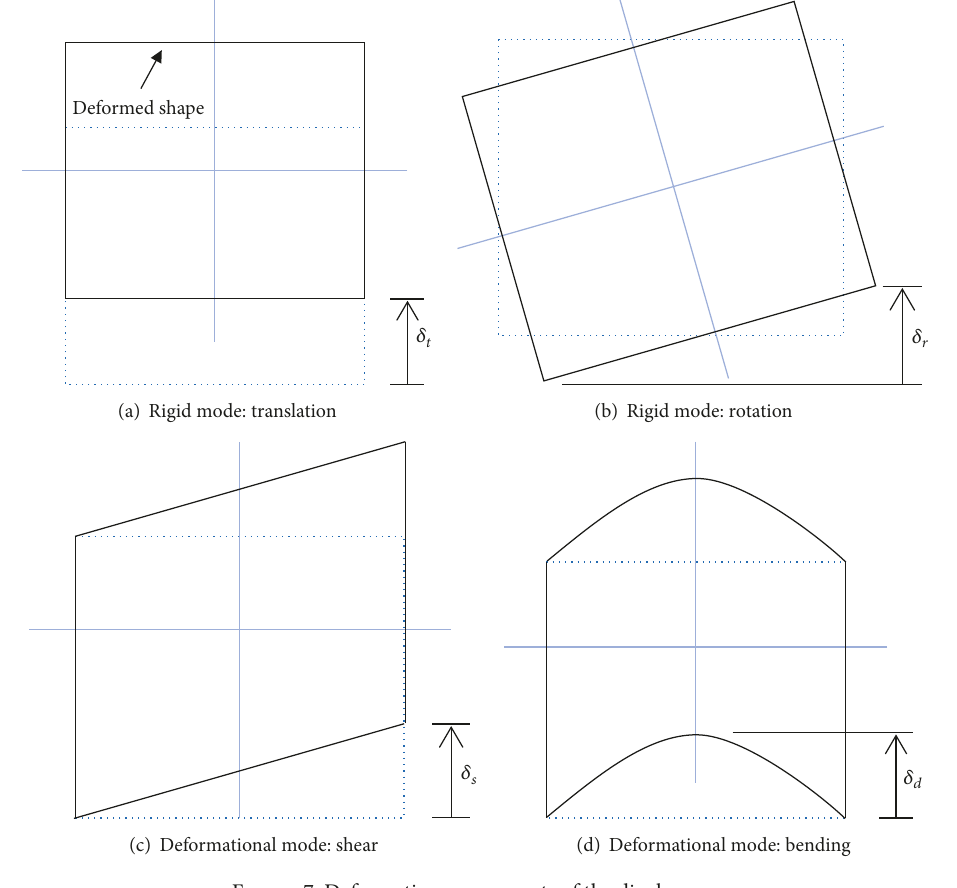
Figure 7: Deformation components of the diaphragm.